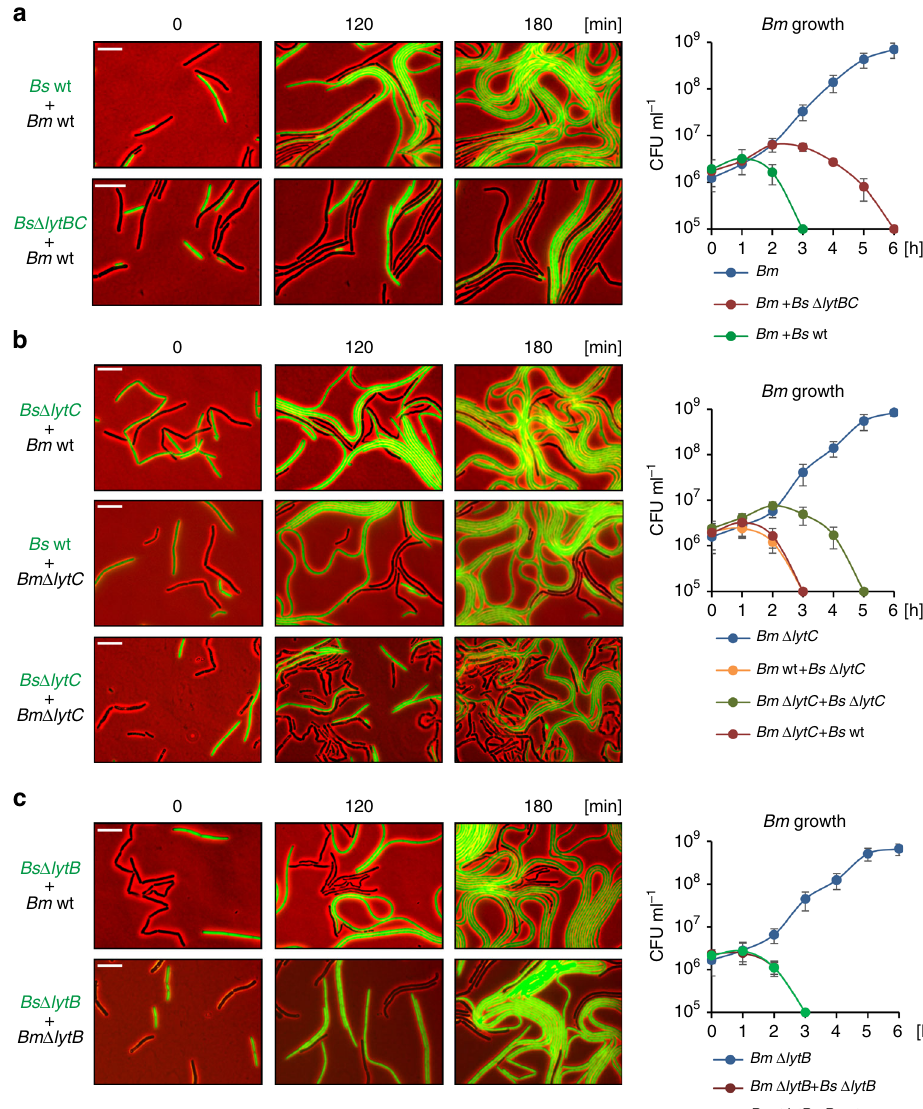
Fig. 7 Inhibition of Bm by Bs is mediated by interspecies pairing of LytB and LytC. a Bm wt (OS2) was mixed with GFP expressing Bs wt (AR16: P rrnE -gfp ) or Bs Δ lytBC (AB264: Δ lytBC , P rrnE -gfp ) and subjected to time lapse microscopy. Shown are overlay fl uorescence from GFP (green) and phase contrast (red) images, captured at the indicated time points. Bm cells are shown in black while Bs cells are shown in green. Graph presents colony-forming unit (CFU/mL) of Bm cells grown alone or in a mixture with the indicated Bs strains. Each time point represents an average value and SD of three independent experiments. b Bm wt (OS2) or Bm Δ lytC (ABm2) were mixed with GFP expressing Bs wt (AR16: P rrnE -gfp ) or Bs Δ lytC (AB227: Δ lytC , P rrnE -gfp